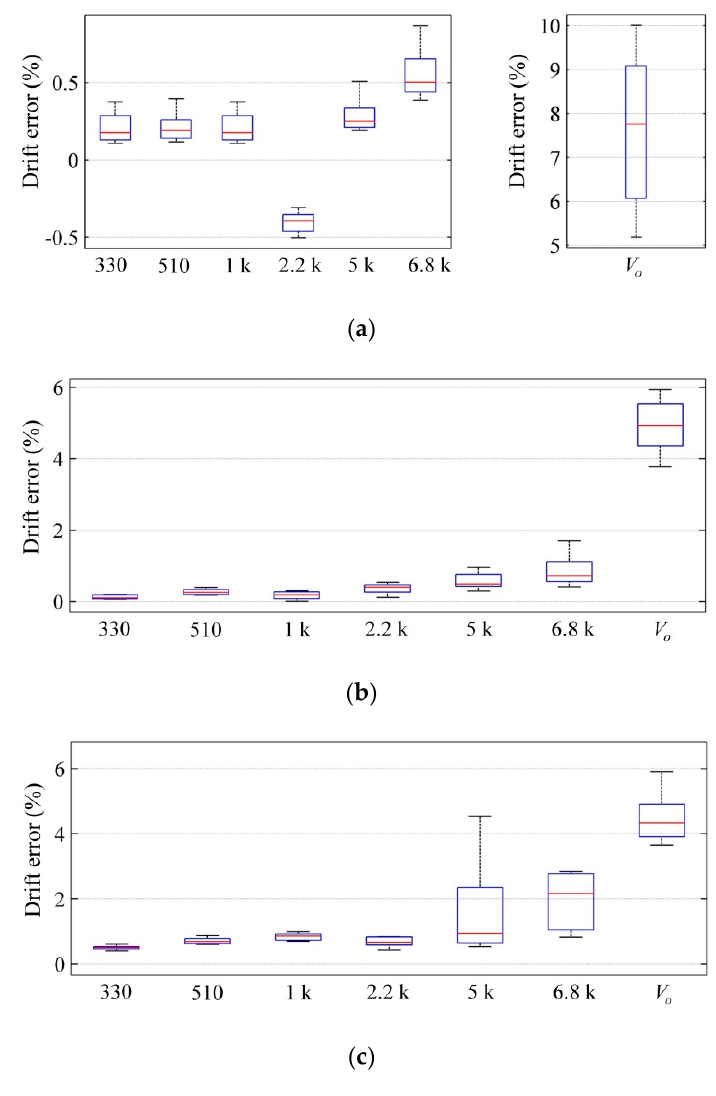
Figure 7. The box plots of the drift in the amplifier output voltage ( V o ) and the resulting frequency ( f ) at different stresses ( σ ). The drift estimated after one hour of operation on the basis of Equations (18) and (19) for V o and f measurements, respectively. The sourcing voltages were set to V FSR = 1.25 V and Vcc = 2.5 V according to the circuits in Figures 3 and 5, respectively. The x-axis of the plots represent the offset resistances employed during each test with R 1 = R 2 and the traditional method ( V o ) at ( a ) σ = 2.3 MPa, ( b ) σ = 1.15 MPa, and ( c ) σ = 0.23 MPa.